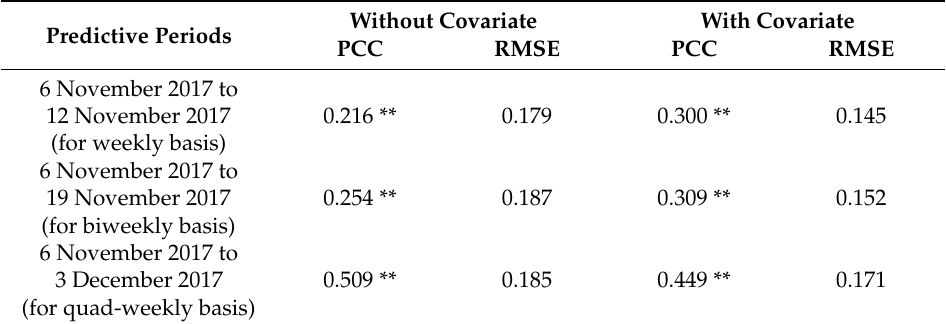
Table 2. The Pearson Correlation Coefficient and the Root Mean Squared Error (RMSE) of the crime prediction. Without Covariate With Covariate Predictive Periods. PCC RMSE